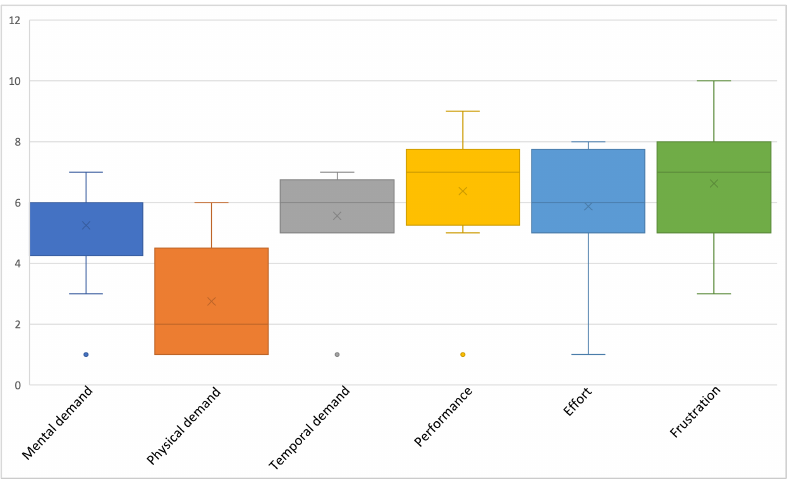
Figure 23. A boxplot of the NASA-TLX result for the analysis of water stress and irrigation requirements use case. Each of the six subscales was captured with a 10-point continuous scale from very low (1) to very high (10) . The X axis indicates the sub-dimensions of the score. The Y-axis indicates the statistics for each